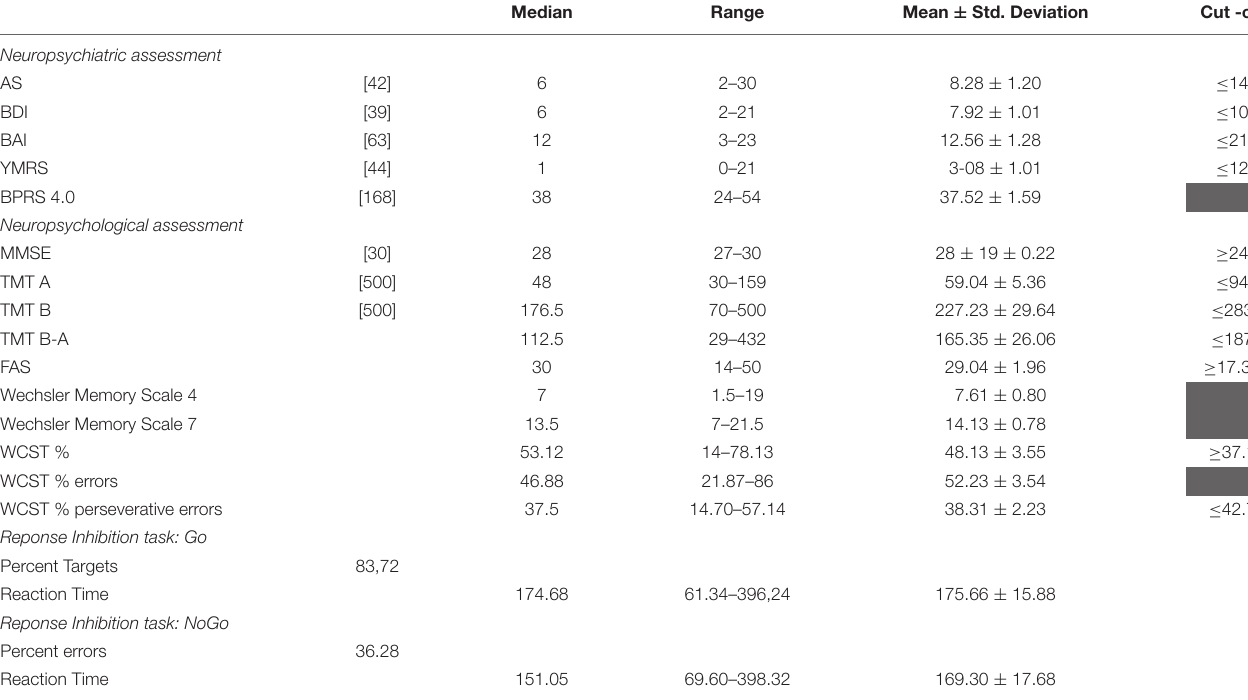
TABLE 2 | Neuropsychiatric and neuropsychological assessment in the on-phase of the disease. Median Range Mean ± Std. Deviation Cut